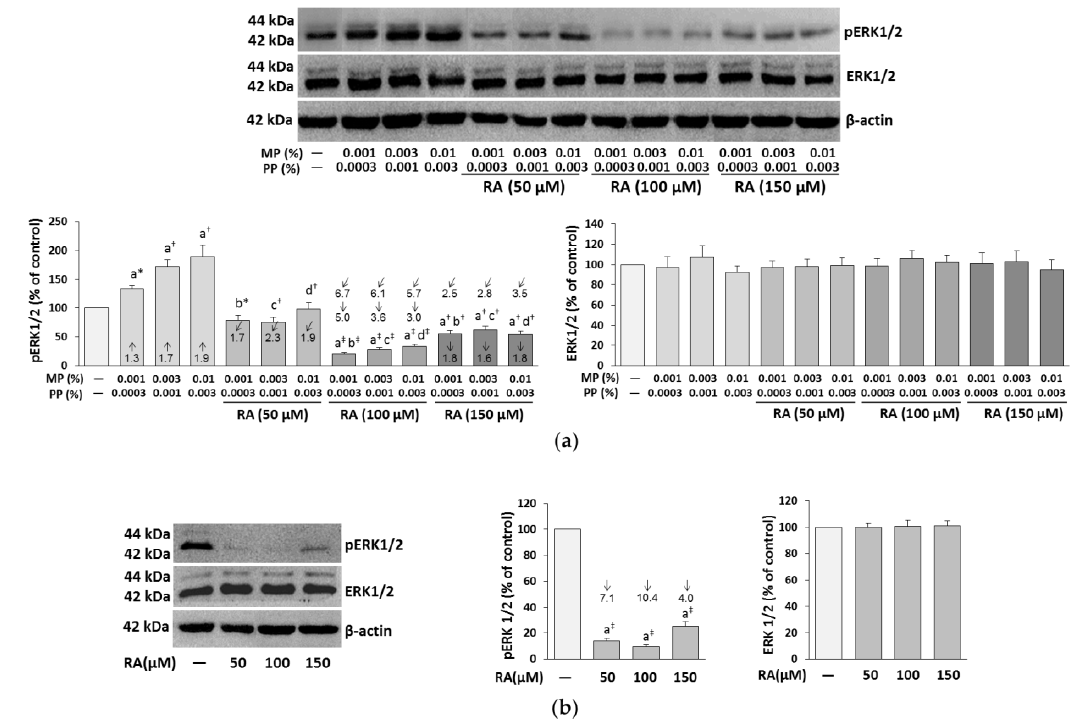
Figure 5. The influence of rosmarinic acid (RA) on the expression of phosphorylated ERK1 / 2 (pERK1 / 2) and total ERK1/2 in the fibroblasts treated with methylparaben (MP) and n-propylparaben (PP) ( a ), and untreated cells ( b ). Representative gels of Western blotting, the intensity of the bands was quantified by densitometry and normalized to β-actin, values represent the mean (% of control) ± SD of three experiments. Statistically significant differences are marked as: a vs. control, b vs. 0.001% MP and 0.0003% PP, c vs. 0.003% MP and 0.001% PP, d vs. 0.01% MP and 0.003% PP; * p < 0.05; † p < 0.01; ‡ p < 0.001. The values in the bars show a factor of change in comparison to the control ( ↑ , increase; , decrease) or to the respective samples treated with parabens alone (MP and PP) ( ↙ , decrease).